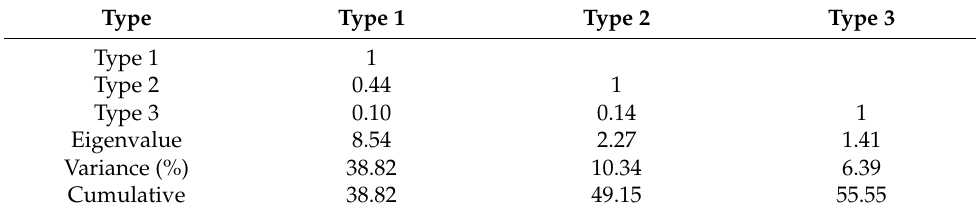
Table 3. Correlations and eigenvalues by